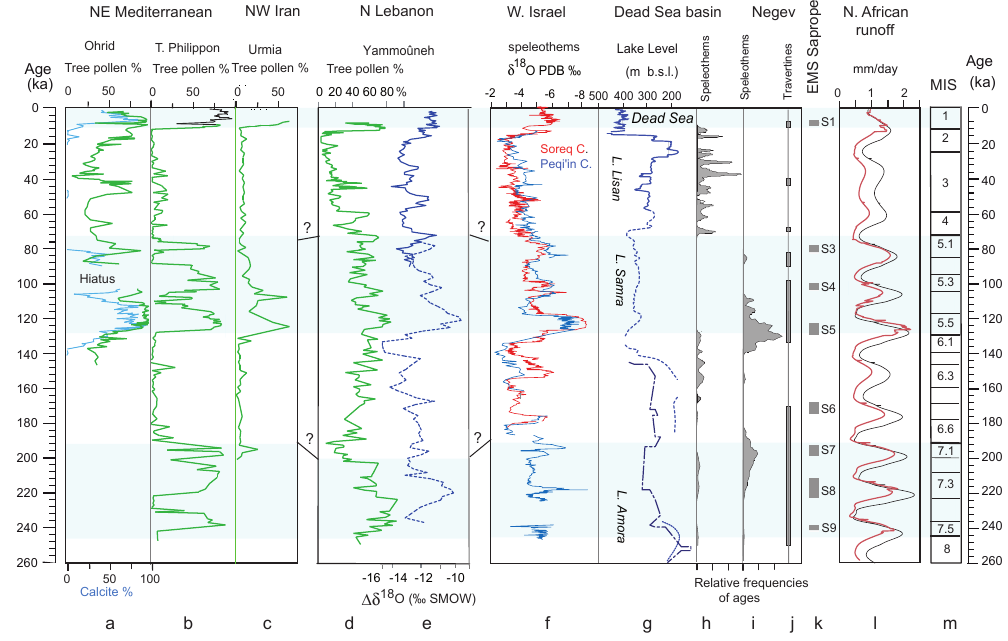
Fig. 11. Environmental changes in the eastern Mediterranean region. (a) – (c) Tree pollen percentages in sediments from a) : Lake Ohrid, Albania (L´ezine et al., 2010); (b) Tenaghi Philippon, Macedonia (Tzedakis et al., 2006); (c) Lake Urmia, NW Iran (Djamali et al., 2008). (d) – (e) Yammoˆuneh proxy data. (d) Tree pollen percentages (as Fig. 10e); (e) 1δ 18 O: (as Fig. 10g). (f) δ 18 O record from Soreq and Peqi’in Caves speleothems, western Israel (Bar-Matthews et al., 2003). (g) Lake level fluctuations of the Dead Sea and its predecessors (Waldmann et al., 2010). (h) Relative frequency of ages of speleothem deposition in the Dead Sea basin (Lisker et al., 2010). (i) Relative frequency of ages of speleothem deposition in the Negev (Vaks et al., 2010). (j) Periods of travertine deposition deposition in the Arava valley (Waldmann et al., 2010). (k) EMS sapropel events (Ziegler et al., 2010). (l) Simulated North African runoff to the eastern Mediterranean basin as an indicator of African monsoon (Ziegler et al., 2010). Results from the CLIMBER-2 model using orbital forcing only (black curve), orbital forcing+varying NH ice sheets and greenhouse gas concentrations (red curve). (m) MISs (Martinson et al., 1987).